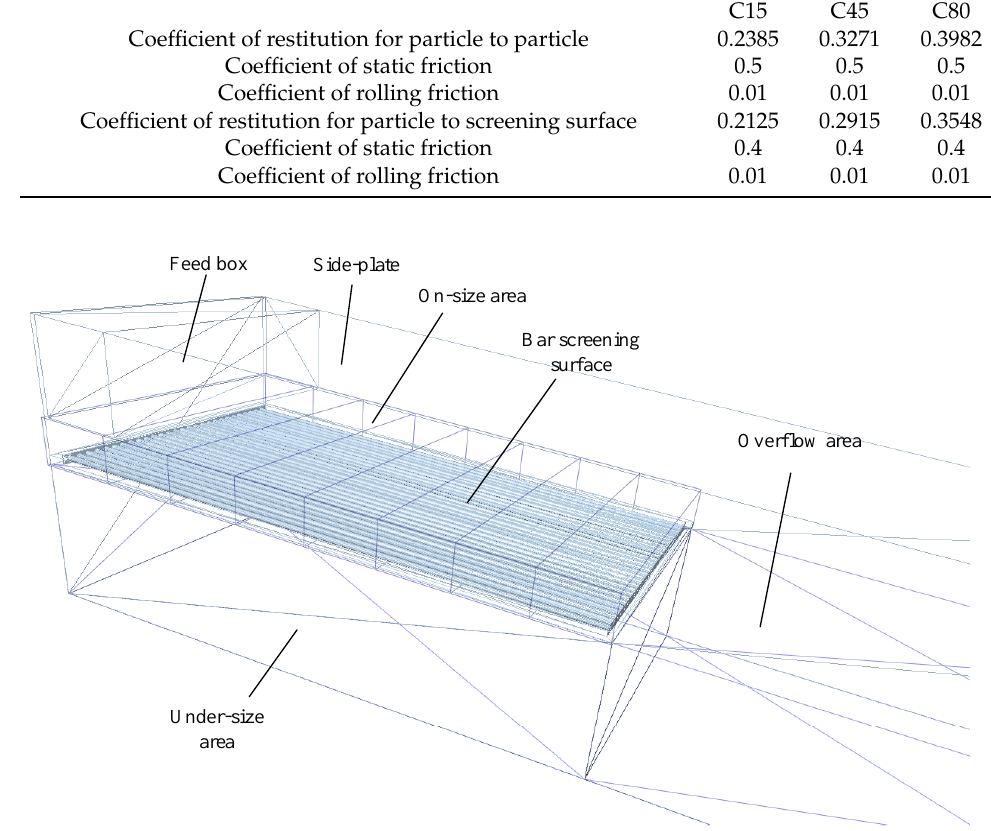
Figure 4. The CAD model of the circular vibrating screen.